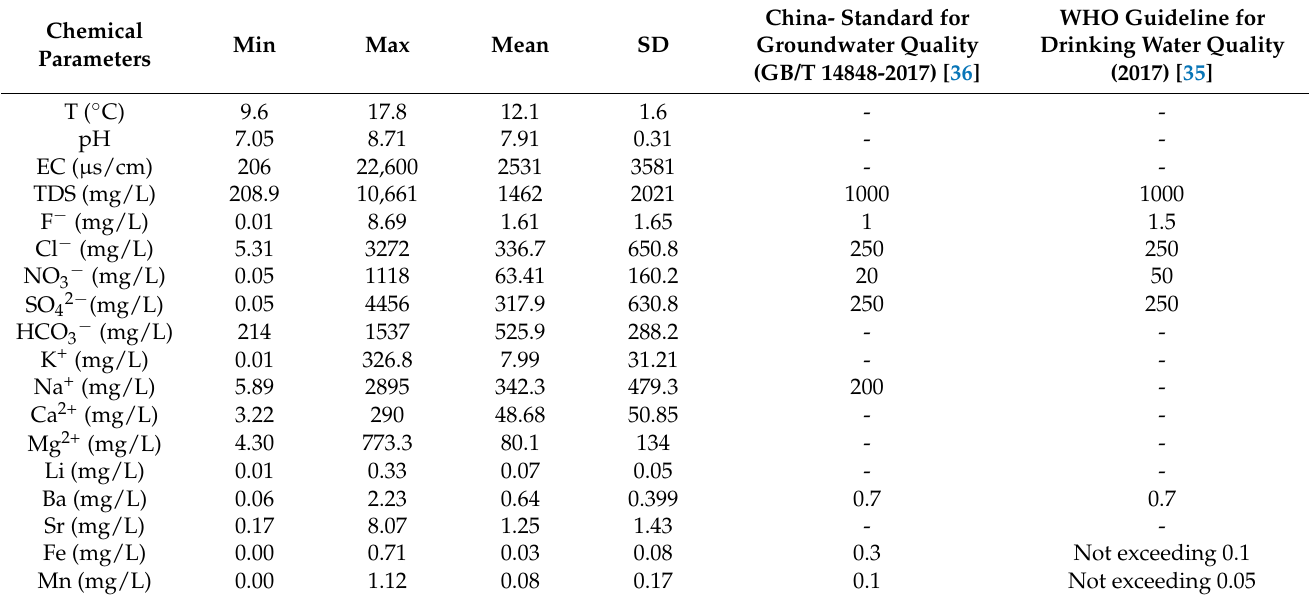
Table 1. Statistical results of the hydrochemical analysis of